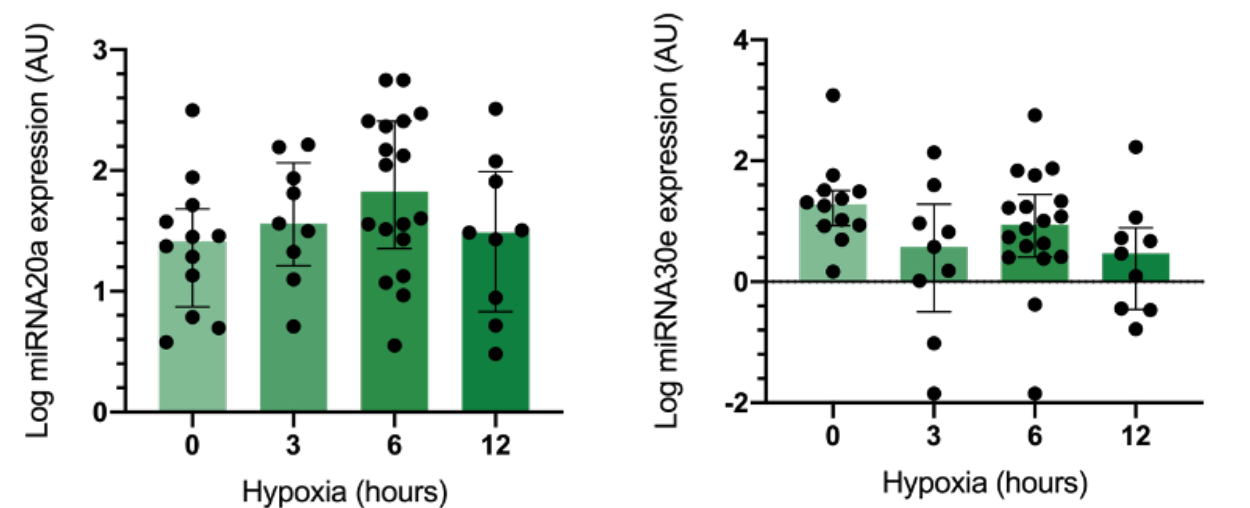
Figure 4. The expression of miRNA-20a was upregulated ( p = 0.049), and the expression of miRNA-30e was downregulated ( p = 0.035) in cultures of GMSCs exposed to a hypoxic environment. The relative miRNA expression was determined by qRT-PCR and normalized with U6. (au): arbitrary units.